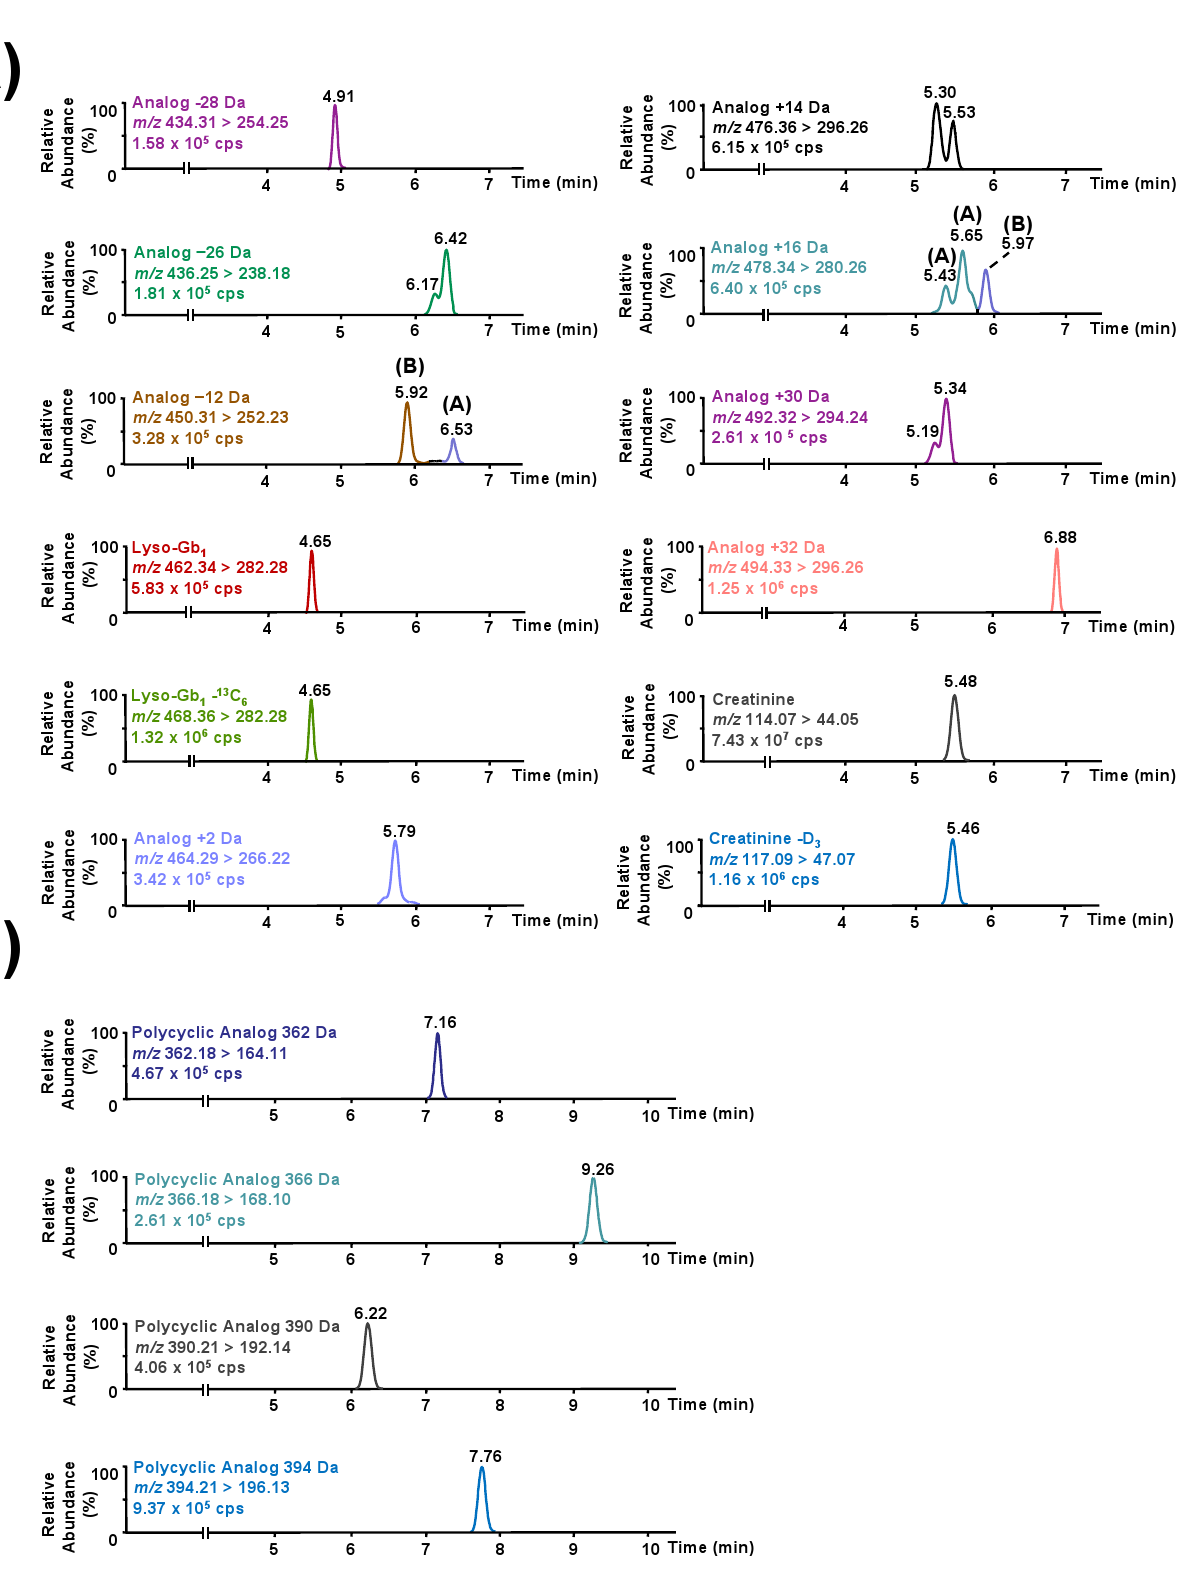
Figure 3. Chromatographic separation of potential lyso-Gb 1 biomarkers and creatinine with their respective internal standards. ( A ) Ion chromatograms using a MRM mode for lyso-Gb 1 , lyso-Gb 1 - ( 13 C 6 ), lyso-Gb 1 analogs, as well as creatinine in a GD patient urine sample. ( B ) Ion chromatograms